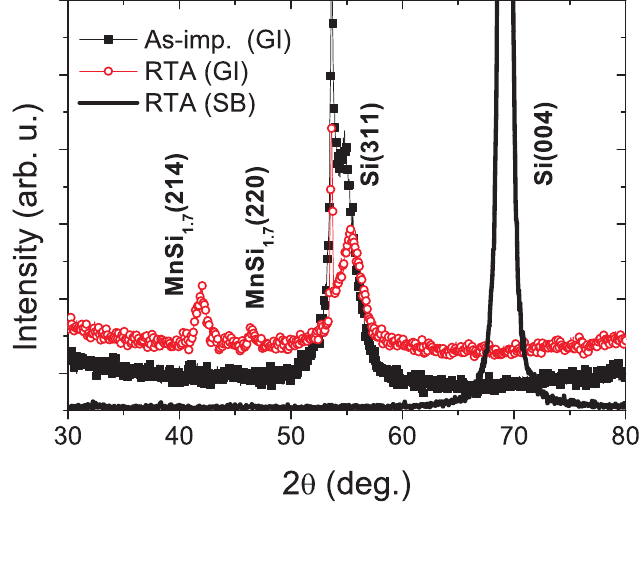
Figure 17 . XRD patterns of Mn implanted Si. GI: grazing incidence, and SB: symmetric beam path. The diffraction peaks at around 42 ◦ and 46.3 ◦ cannot be attributed to the Si substrate, but to MnSi . (Reprinted with permission from Ref. [68]. Copyright 2007 by the 1 . 7 American Physical